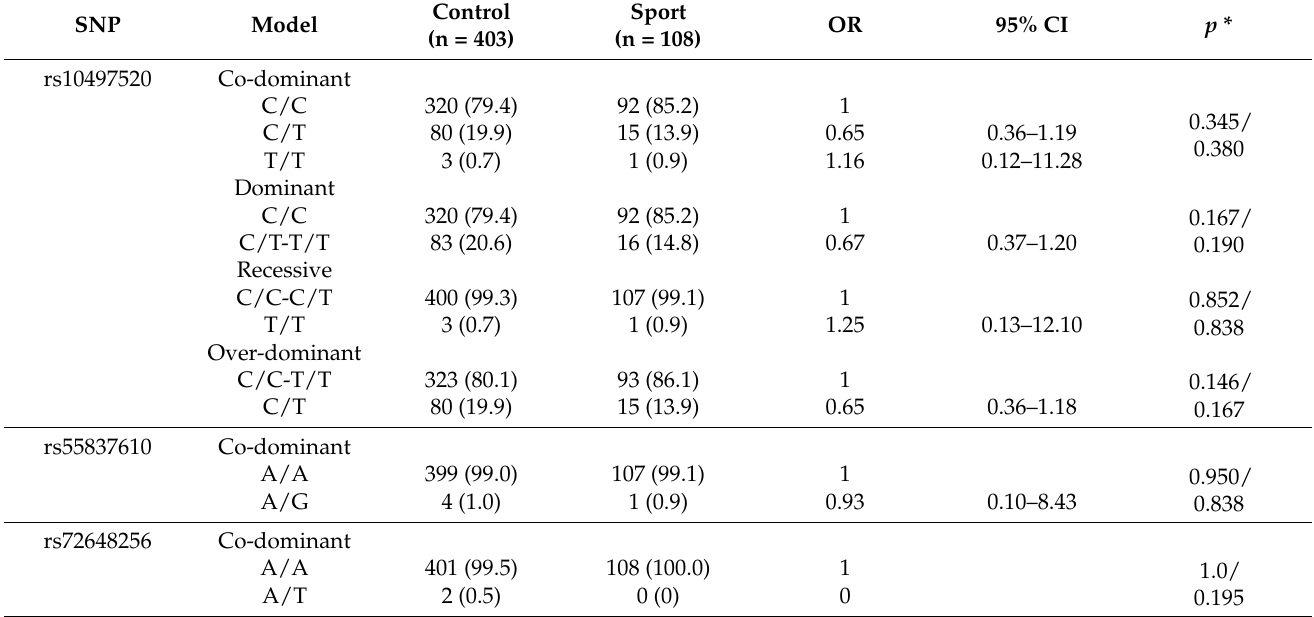
Table 3. Single SNP association analysis for cases (endurance sports) and controls.